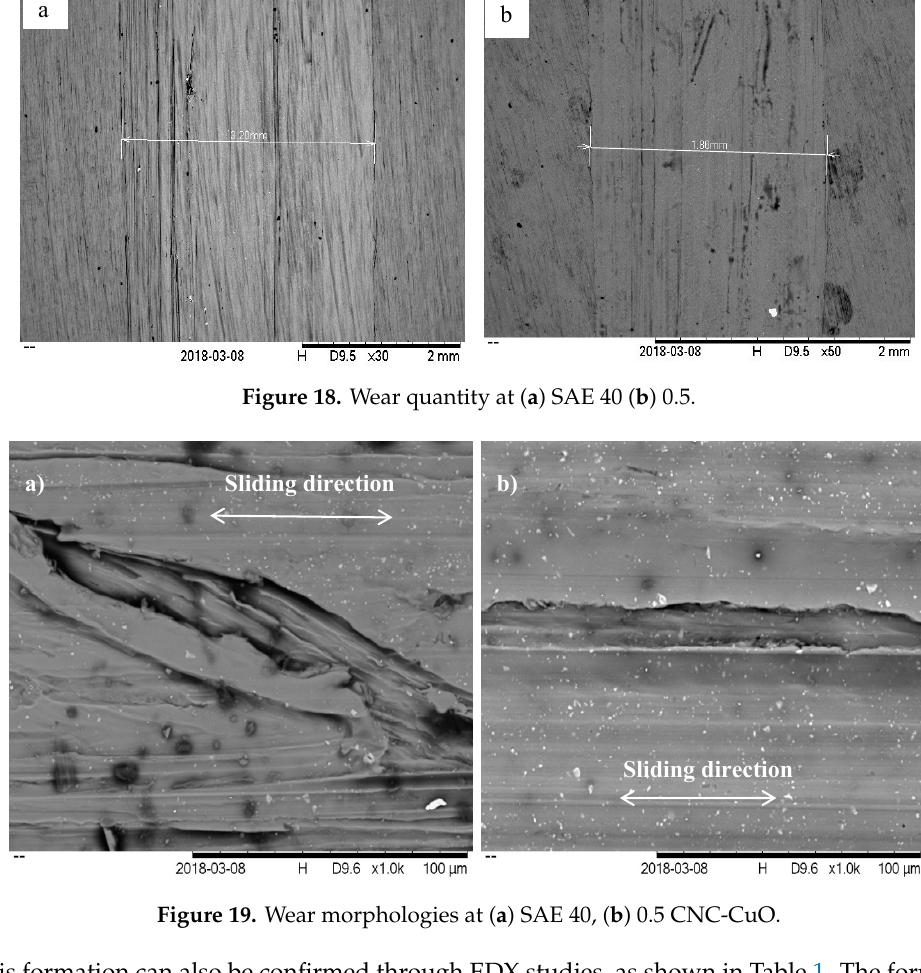
Table 2. Percentage of the element according to EDX spectrum.